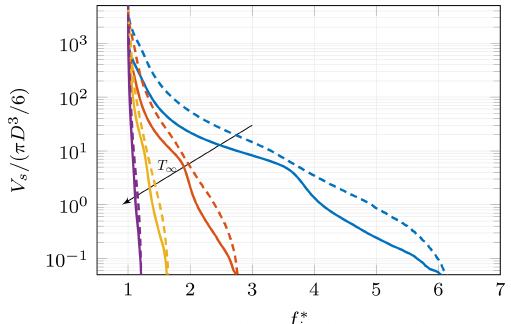
Figure 8. Volume of air with supersaturation above a given thresh- old as a function of the ice enhancement factor. The volume is nor- malized by the volume of the ice particle, and four different tem- peratures are shown: T ∞ = − 6 ◦ C (purple), T ∞ = − 9 ◦ C (yellow), T ∞ = − 12 ◦ C (red) and T ∞ = − 15 ◦ C (blue). Solid lines corre- spond to Re = 600 (chaotic regime, time average), while dashed lines show the data obtained for Re = 75 (axisymmetric